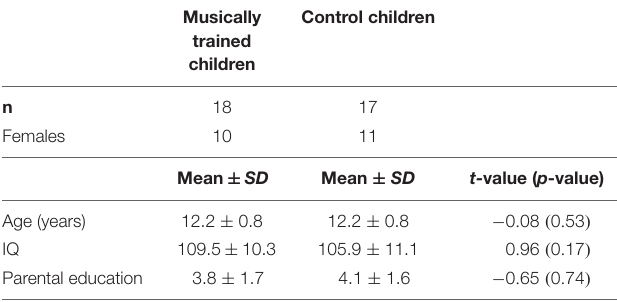
TABLE 1 | General demographics of the study population.